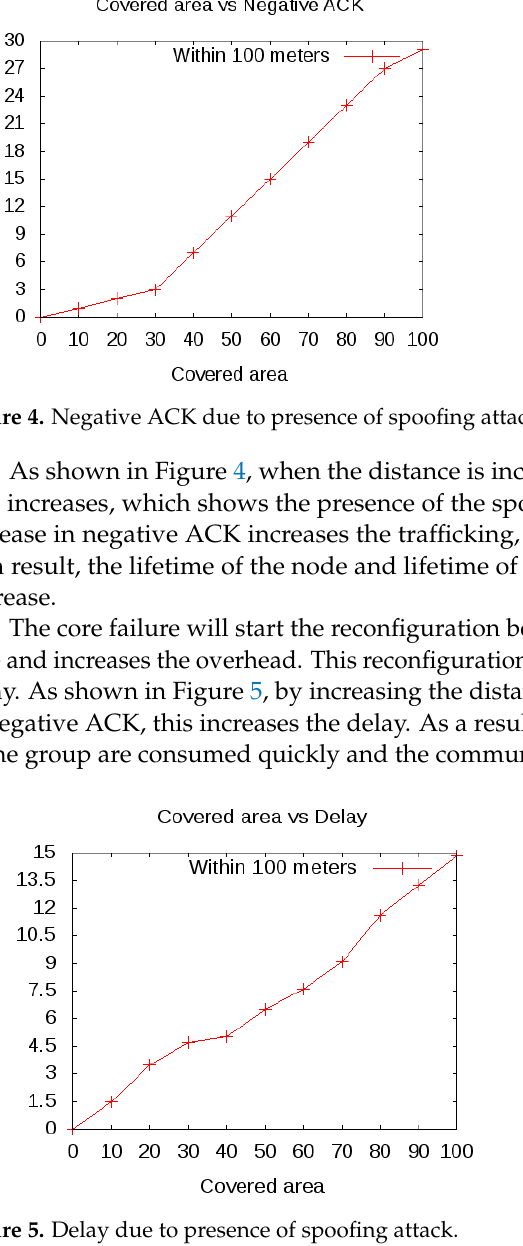
Figure 6. Negative ACK due to absence of spoofing attack.